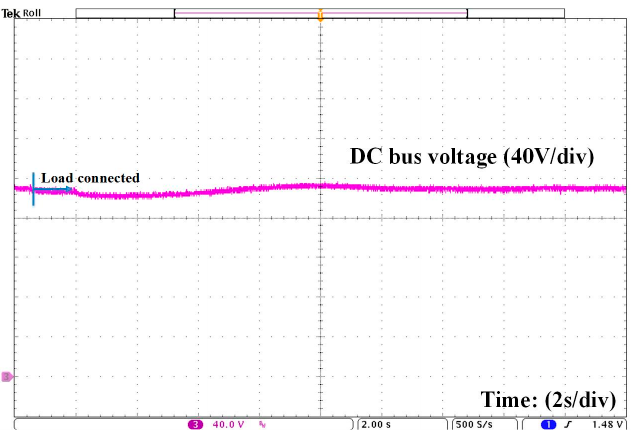
Figure 29. Connection of 400 W fluorescent lamps.